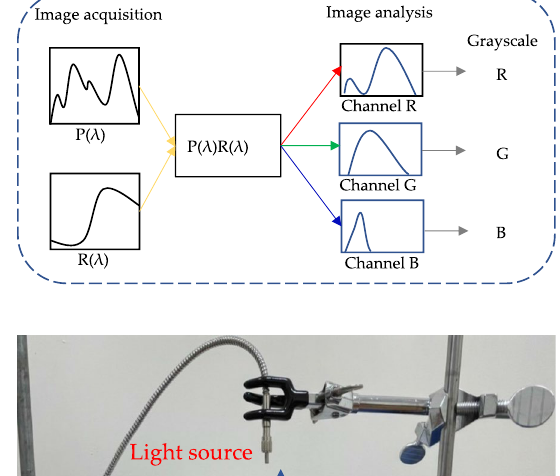
Fig. 3 The experimental setup for direct bilirubin detection by spectral analysis of color images